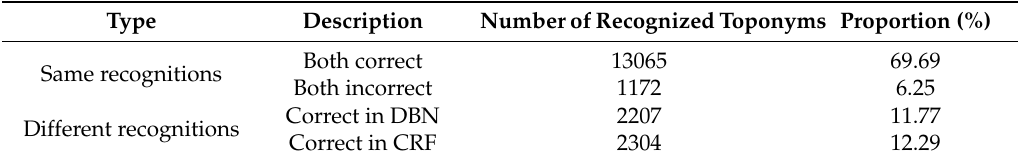
Table 8. Different types of recognized toponyms by DBN and